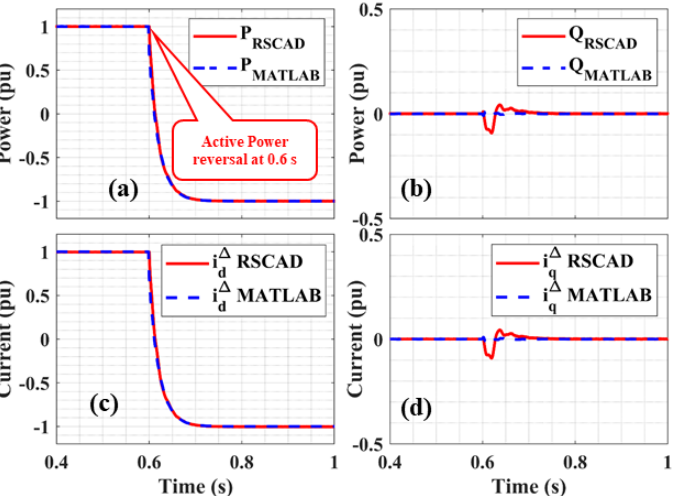
Figure 10. Comparison of: ( a ) active power; ( b ) reactive power; ( c ) output current i ∆ current i ∆ q ; in MATLAB (blue) and RSCAD (red) during active power reversal from 1 p.u. to -1 p.u. at the time instance t = 0.6 s.